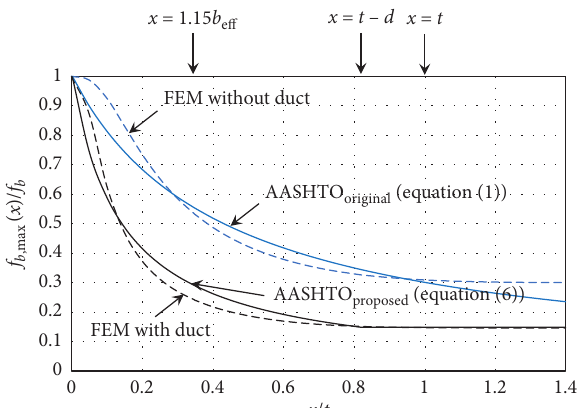
Figure 10: Comparison of longitudinal stress distribution in the cases with and without a duct hole ( b a duct